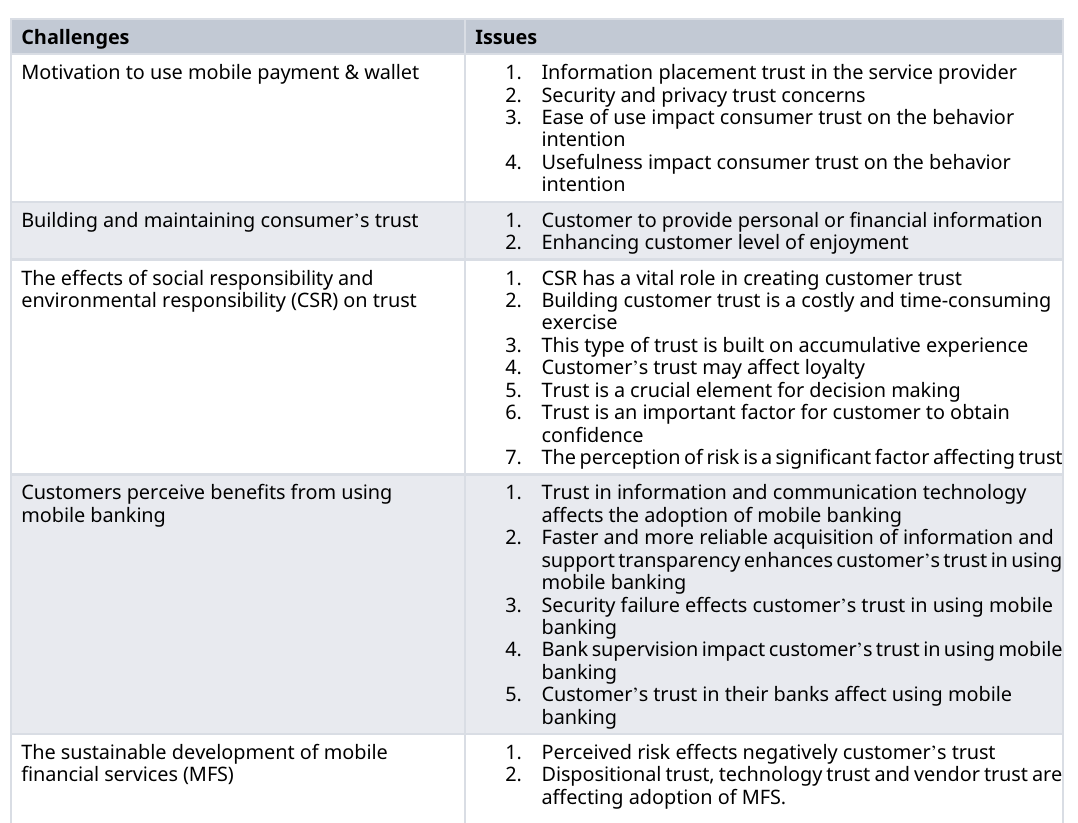
Table 6. Challenges discussed in selected